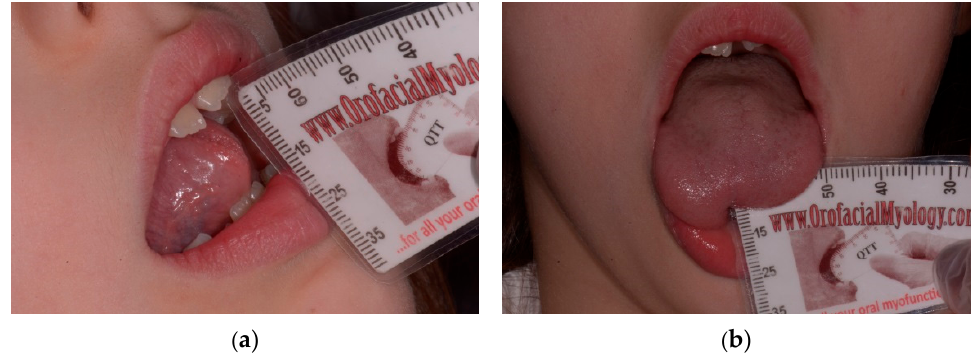
Figure 2. Quantitative variables at T0: ( a ) MOTTIP; ( b )